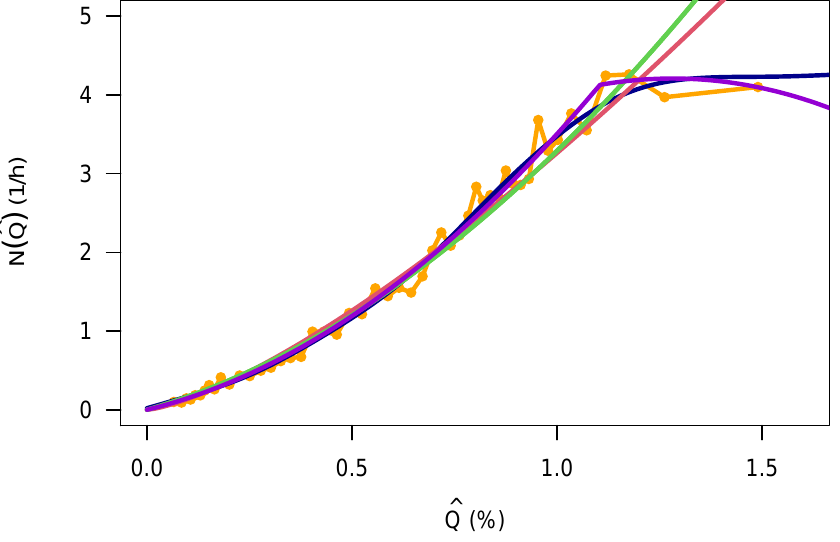
Figure 13. N versus Q for the severe crashes only, again with the empirical data and the four differ- ent